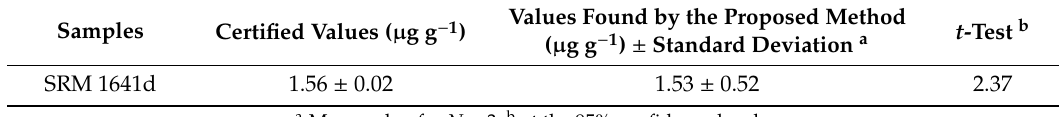
Table 3. Analytical method validation by analyzing the standard reference material (SRM). Samples